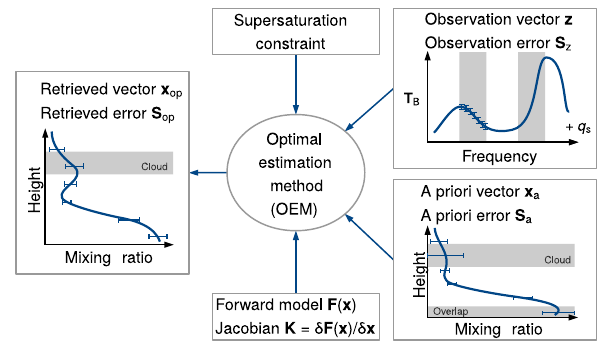
Figure 5. Retrieved mixing ratio profiles both with (red) and with- out (green) supersaturation constraint on 23 April 2013, 01:02UTC. Cloud base is indicated by the dashed line. The saturation mixing ratio is illustrated by the dotted grey line. The a priori profile (blue) for both scenarios is the same.